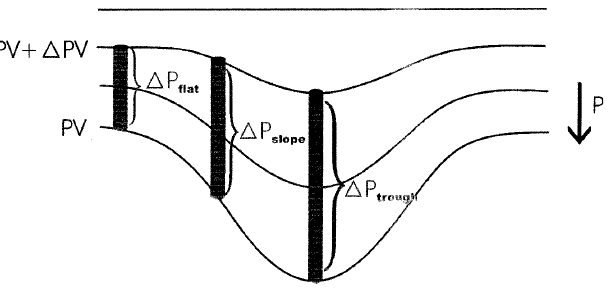
Fig. 6. Illustration of j o p = o PV j around a tropopause trough. j o p = o PV j at a sloping tropopause and at a tropopause trough is generally larger than j o p = o PV j at a flat tropopause